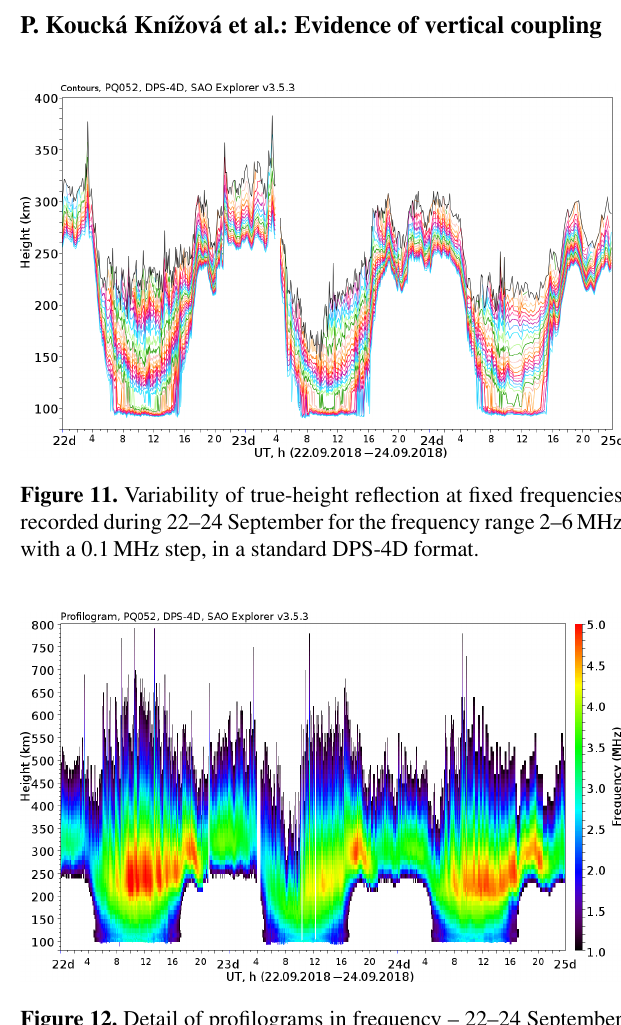
Figure 12. Detail of profilograms in frequency – 22–24 September presented in an a standard DPS-4D format.